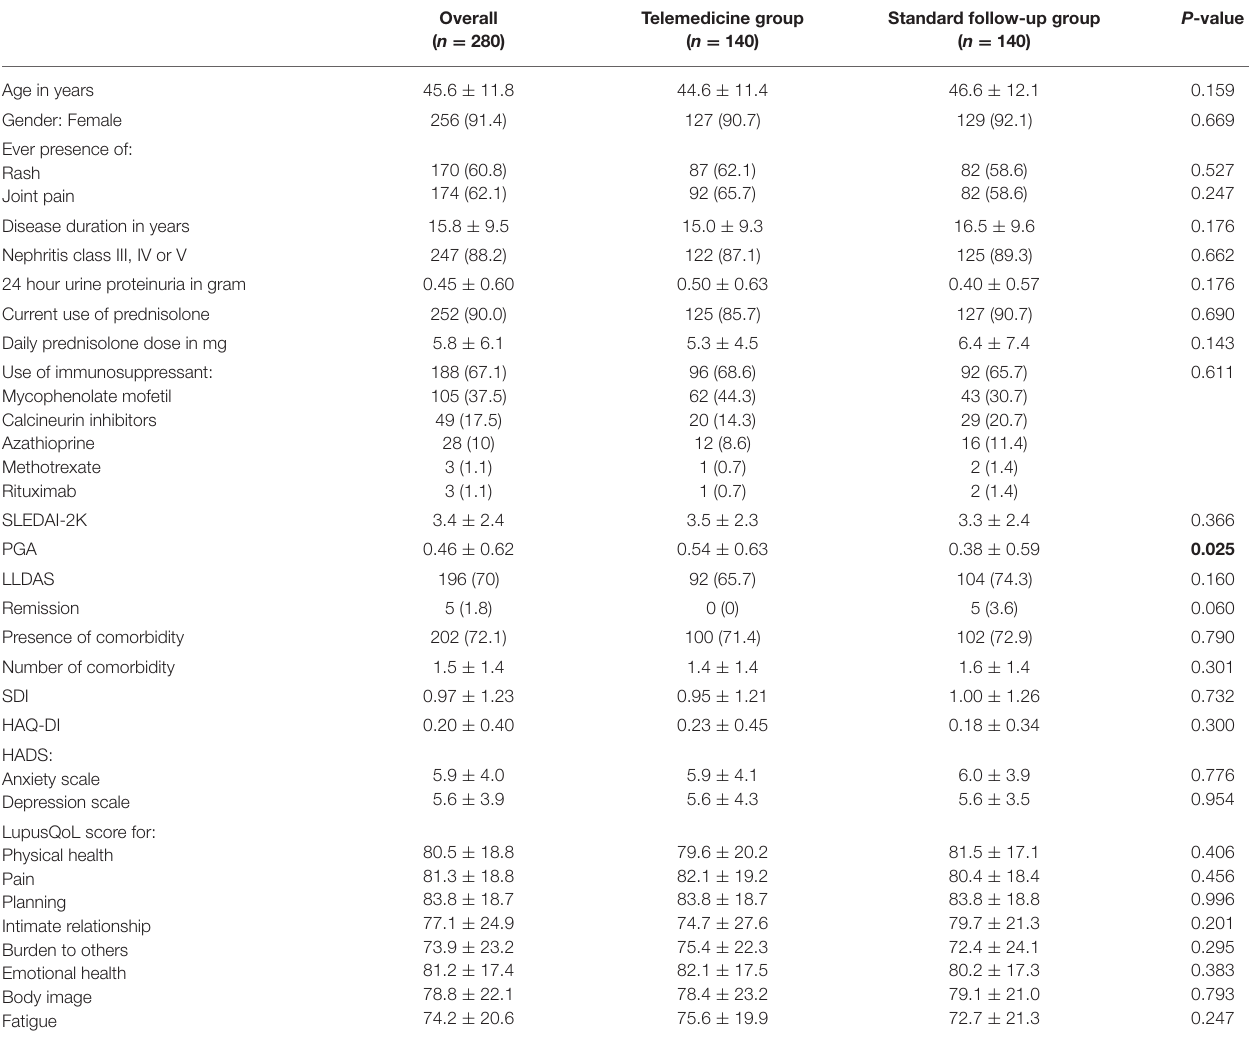
TABLE 1 | Disease data of the recruited patients and comparison between the telemedicine/standard follow-up groups.